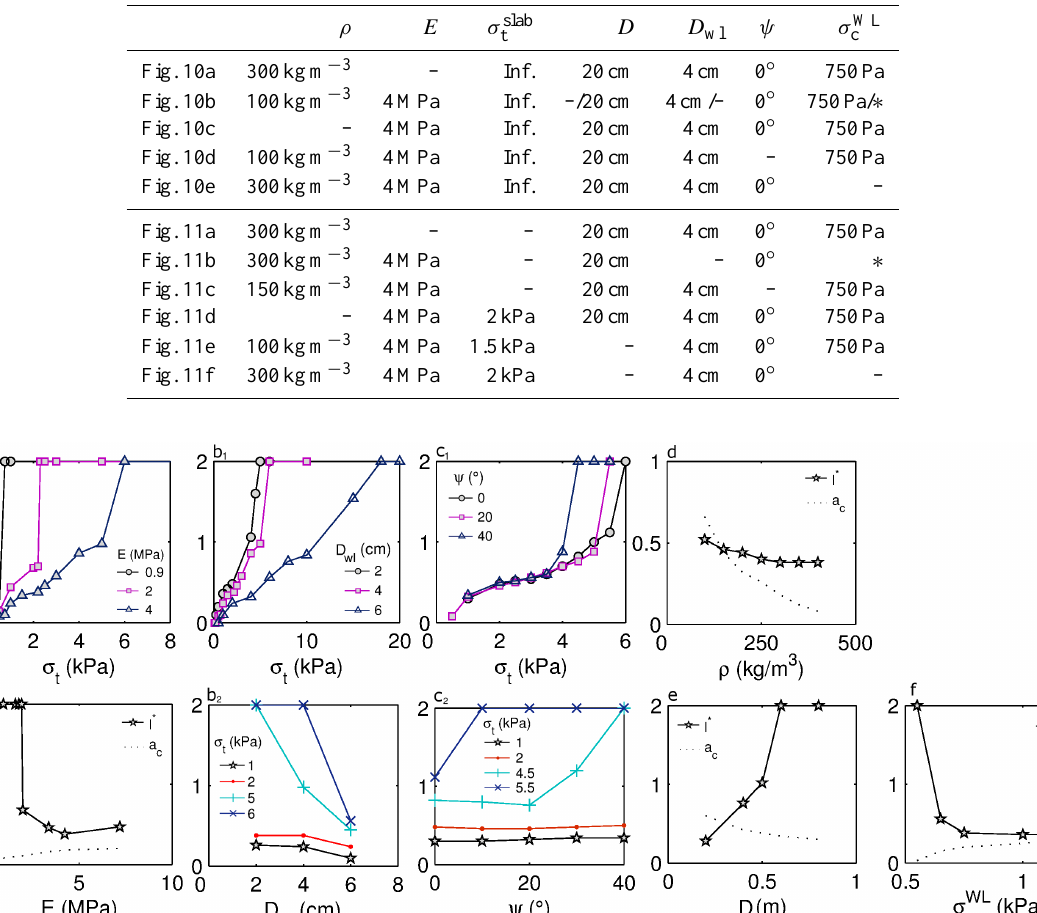
Table 3. Table of the parameter values used for Figs. 10 and 11. The symbol “–” means that the associated parameter was varied. The symbol ∗ means that the WL failure envelope was calibrated to obtain a constant critical length a c = 15cm.